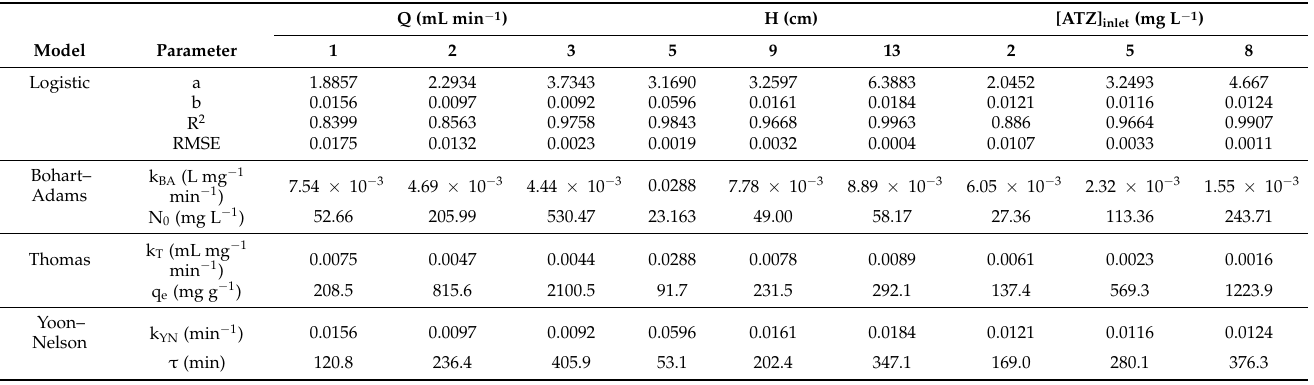
Table 3. Parameters of the models fitted to the experimental data operating the packed-bed adsorption